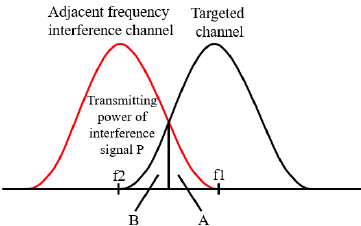
Figure 1. Power distribution of transmitting and receiving signals.